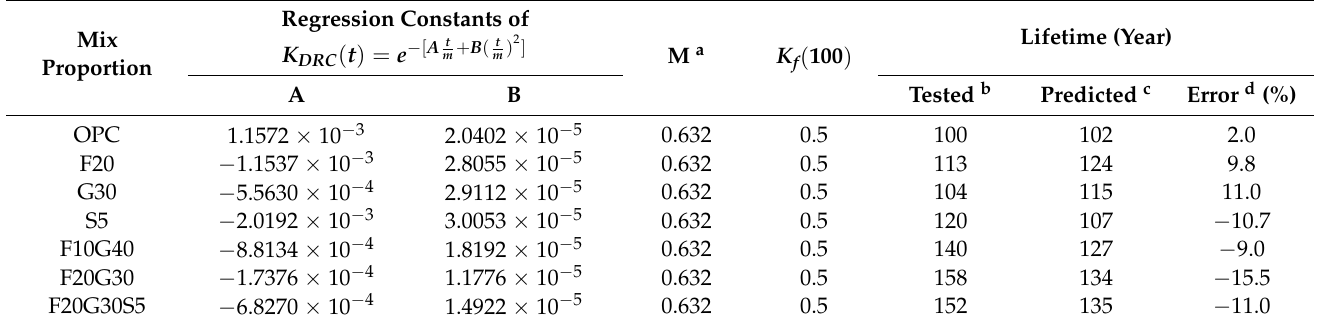
Table 9. Service life prediction